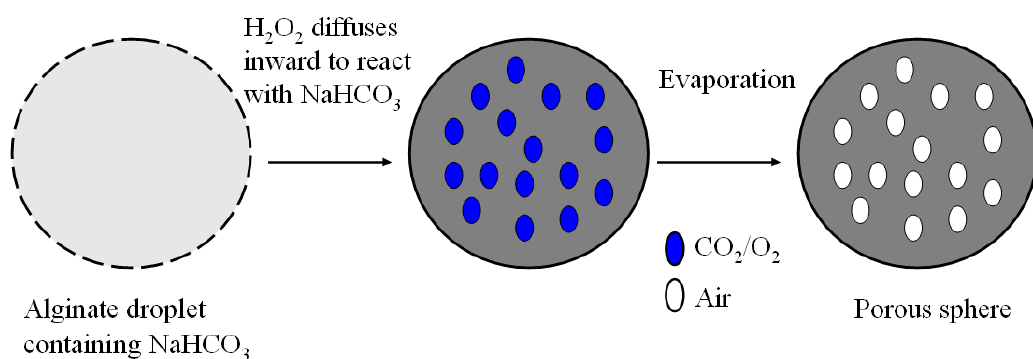
Figure 7. Schematic picture of structure evolution within a microparticle to form